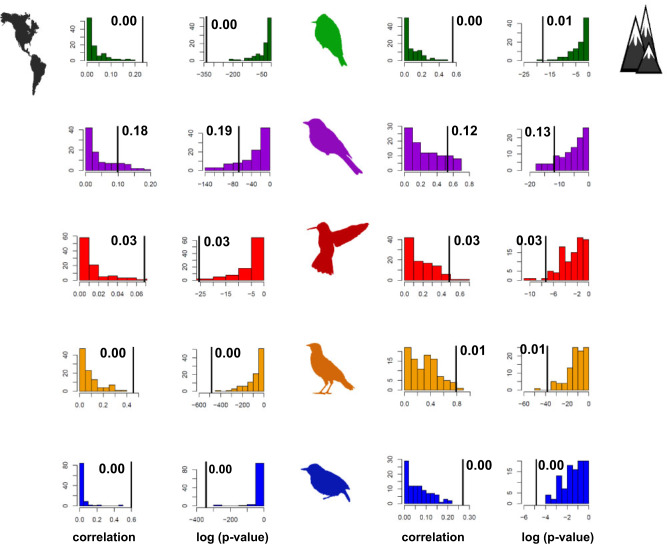
Null models for the correlation between diversification rates and NRI. The results confirm that the empirical correlation (Figs. 5 and 6) cannot be explained solely by the structure of the underlying data (i.e., the phylogeny, the number of species occurring within each region, and the number of regions that each species occupies). Empirical results (vertical lines) are compared against the null results for each taxon separately across regions (panels on the left) and elevations (panels on the right). Taxon-specific silhouettes and color-coding correspond with the preceding figures. Vertical axis indicates the frequency with which the different null results were observed.